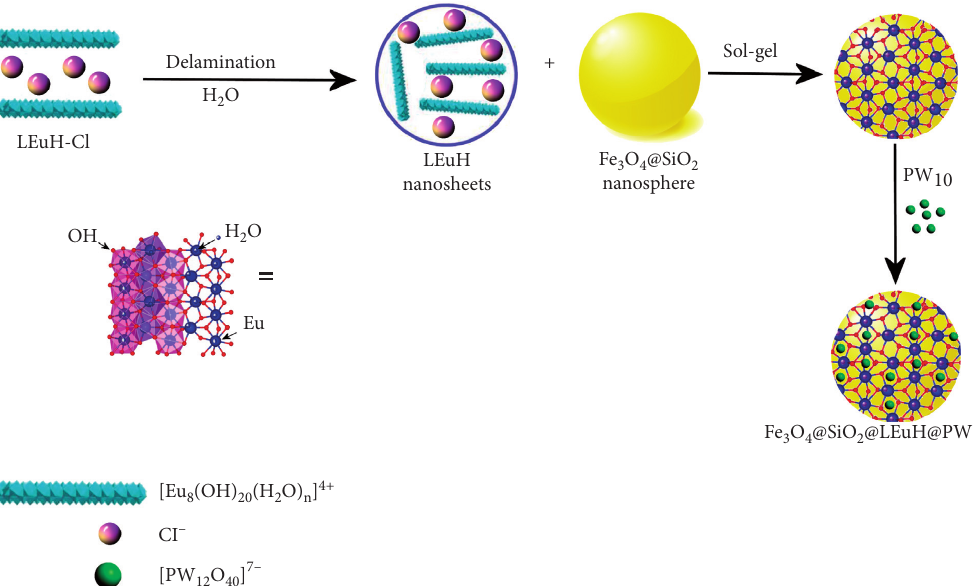
Figure 2: Proposed synthetic pathway of preparing Fe clarity.